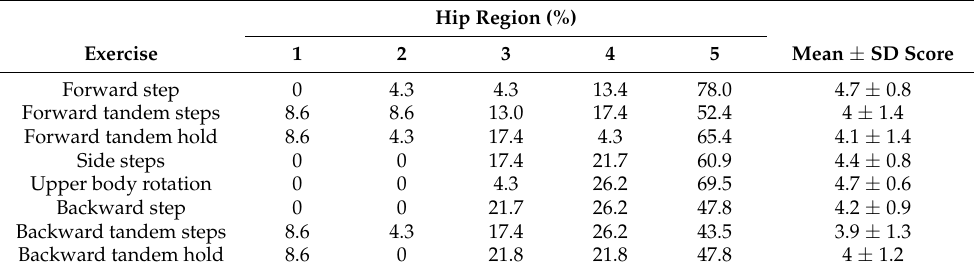
Table 3. Comfort scores of the exercises performed at the hip region.